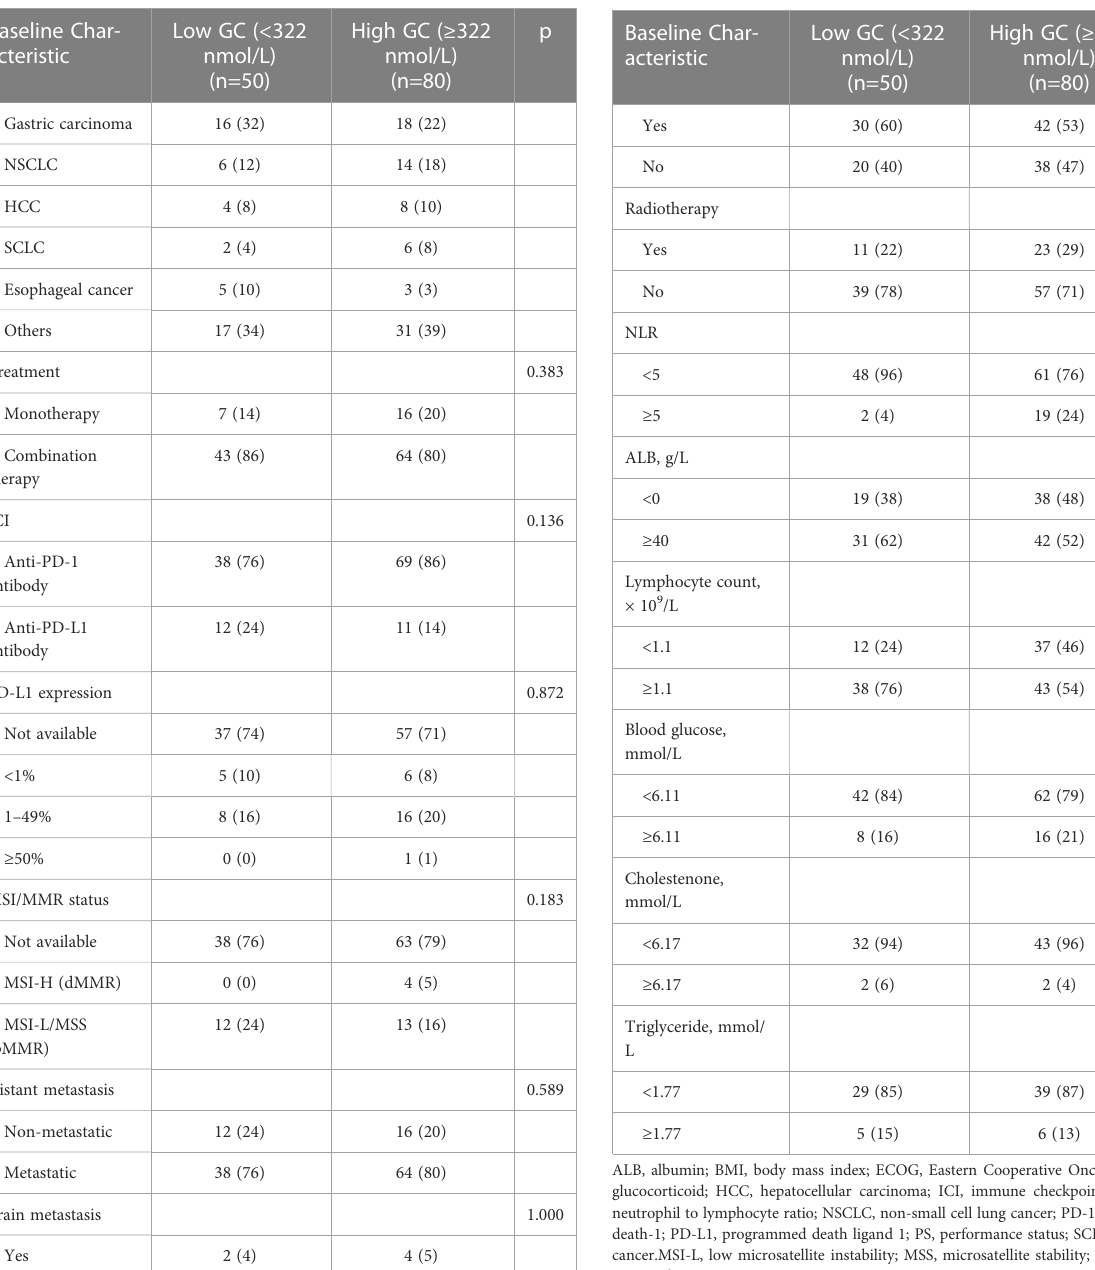
(Figure 2E). High endogenous GC levels remained associated with reduced ORR in patients with gastric cancer (p=0.005), and the ORR was 6.0% and 43.7% in high and low GC levels group, respectively (Figure 2F). As for survival analysis, the patients with high endogenous GC levels had a poorer median PFS (3.5 vs 8.3 months; HR 2.023; 95% CI 1.364 – 3.001; p=0.0008) and OS (13.7 vs 22.7 months; HR 2.809; 95% CI 1.639 – 4.816; p=0.0005) than those with low endogenous GC level (Figure 3A). Statistically signi fi cant differences regarding PFS (HR 1.816; 95% CI 1.034 – 3.188; p=0.032) and OS (HR 3.084; 95% CI 1.397 – 6.809; p=0.002) were also detected after PSM (Figure 3B). The endogenous GC levels were further con fi rmed